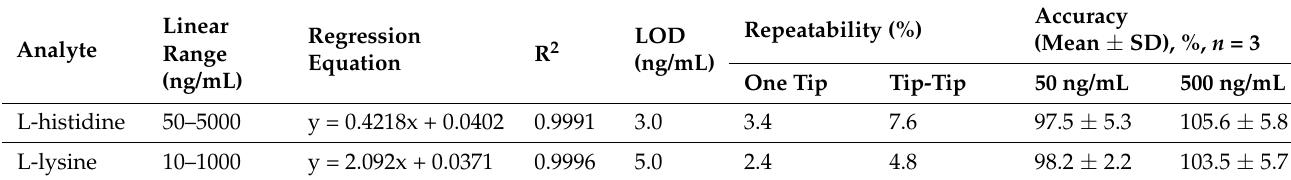
Table 1. Quantitative analysis of L-histidine and